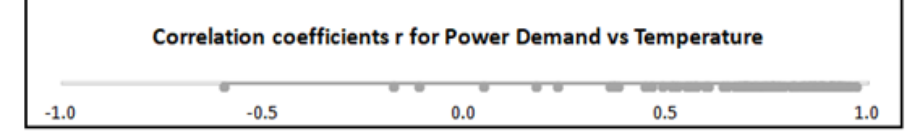
Figure 3. Pearson correlation tests for power demand vs. temperature.